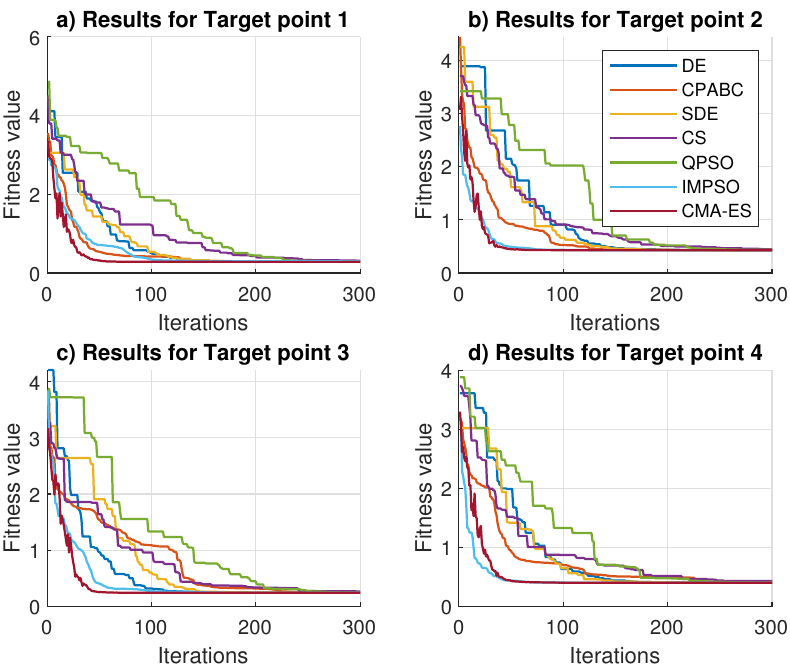
Figure 6. Convergencecurves’ results. The results for the best position errors are